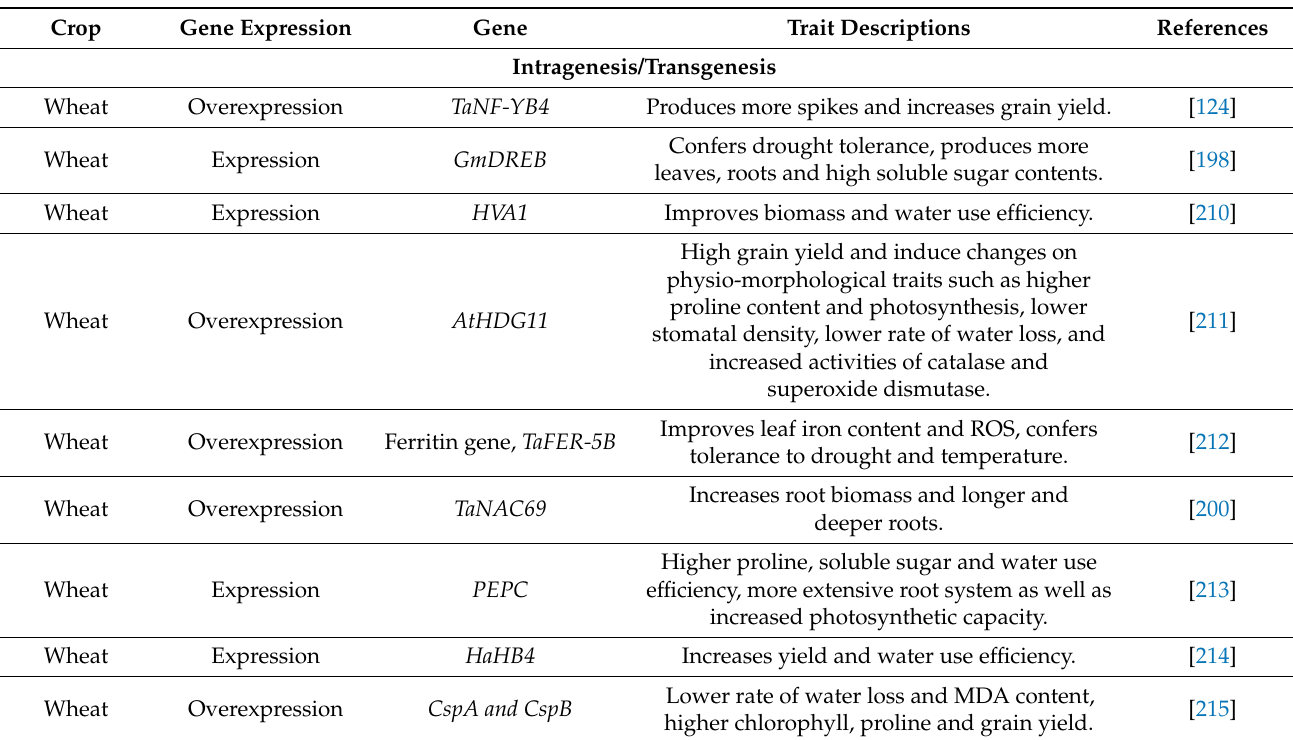
Table 4. The application of biotechnology approaches on various crops